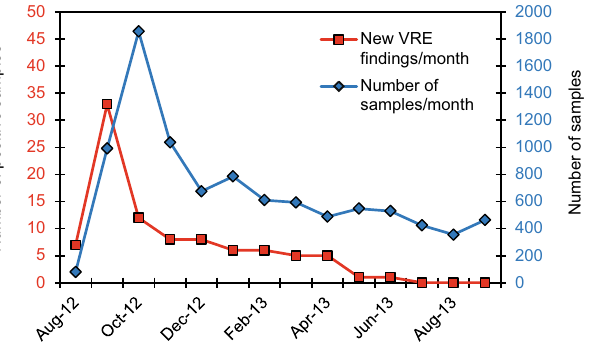
Figure 1. VRE screening during the SØ12 outbreak. Number of screened fecal samples (blue line) and patients positive in at least one sample (red line) during the 2012–2013 VRE outbreak at Østfold Hospital Trust. Distribution of patients positive for VRE was highest in September with 33 positive isolates. By July 2013, no more positive samples were found among the screened